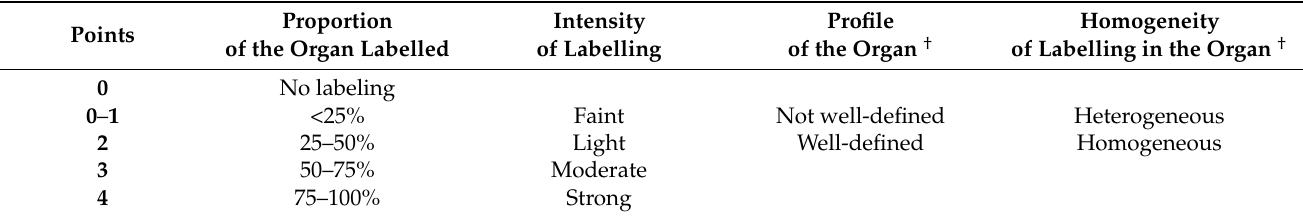
Table A2. Scoring method for radiographic evaluation of gastrointestinal tract